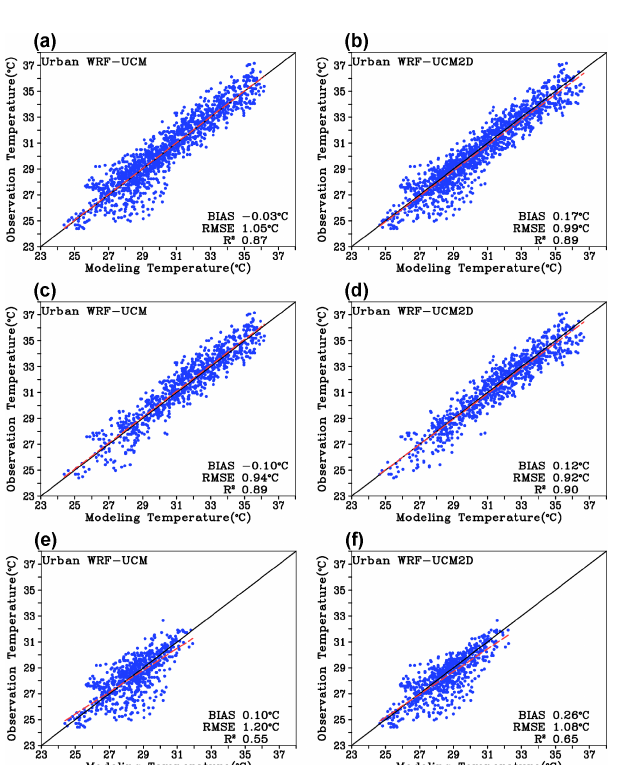
Figure 5. Scatterplots between observed and simulated tempera- tures at 19 urban stations with bias, RMSE, and R 2 calculated us- ing simulated temperatures of (a, b) the entire study period, (c, d) daytime, and (e, f) nighttime obtained by WRF–UCM and WRF– UCM2D, respectively.